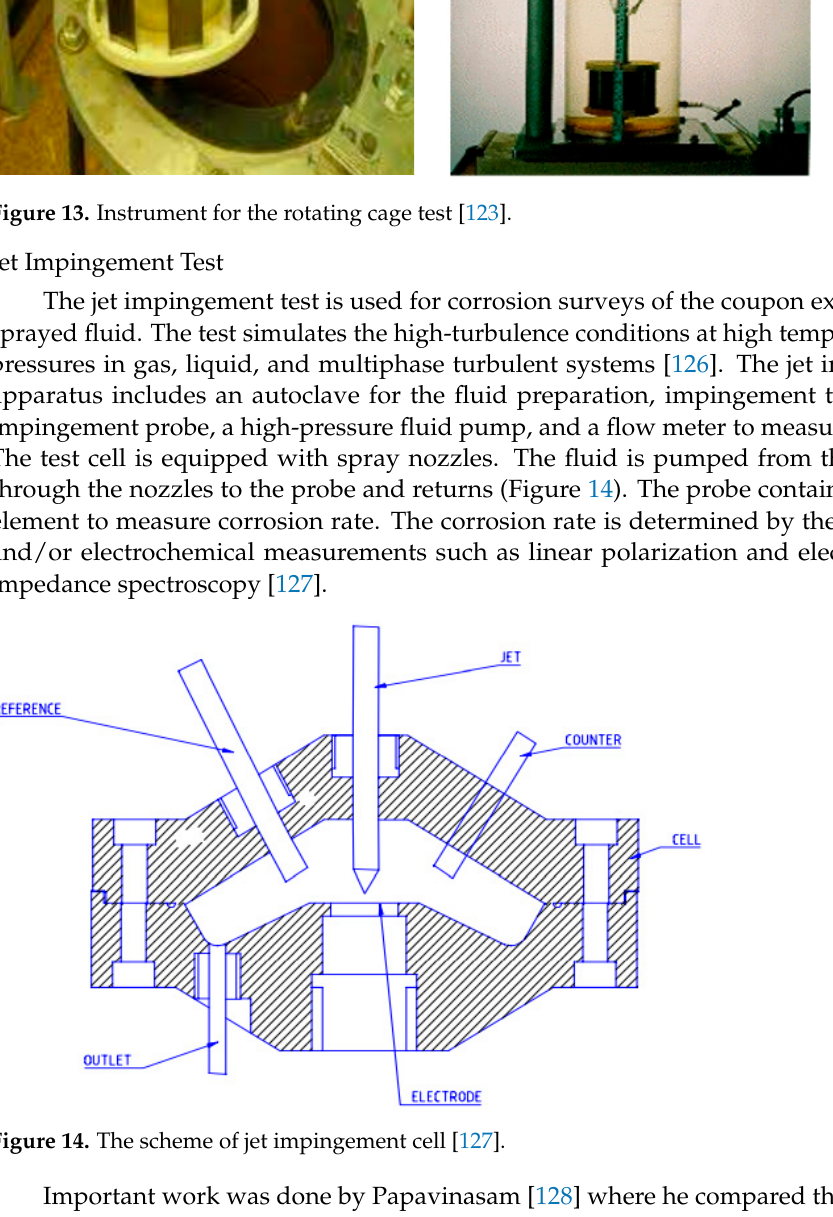
Figure 13. Instrument for the rotating cage test [123].